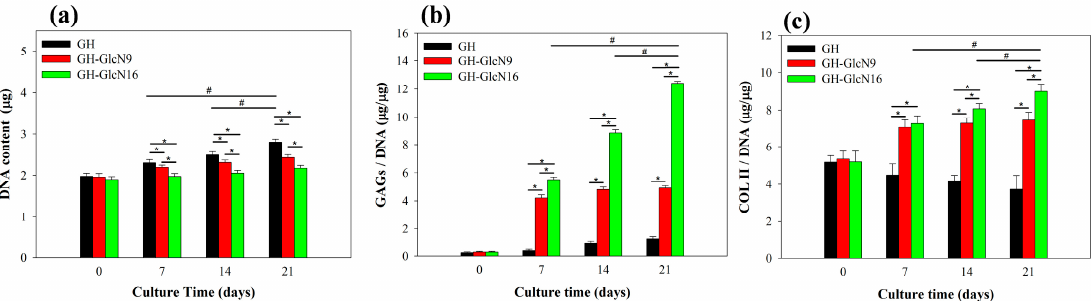
Figure 6. Proliferation and extracellular cellular matrix production of chondrocytes in GH, GH-GlcN9 and GH-GlcN16 cryogels. ( a ) DNA content; ( b ) glycosaminoglycans (GAGs) content normalized to DNA content; ( c ) type II collagen (COL II) content normalized to DNA content. * p < 0.05 compared between different cryogels; # p < 0.05 compared between different time points excluding day 0.